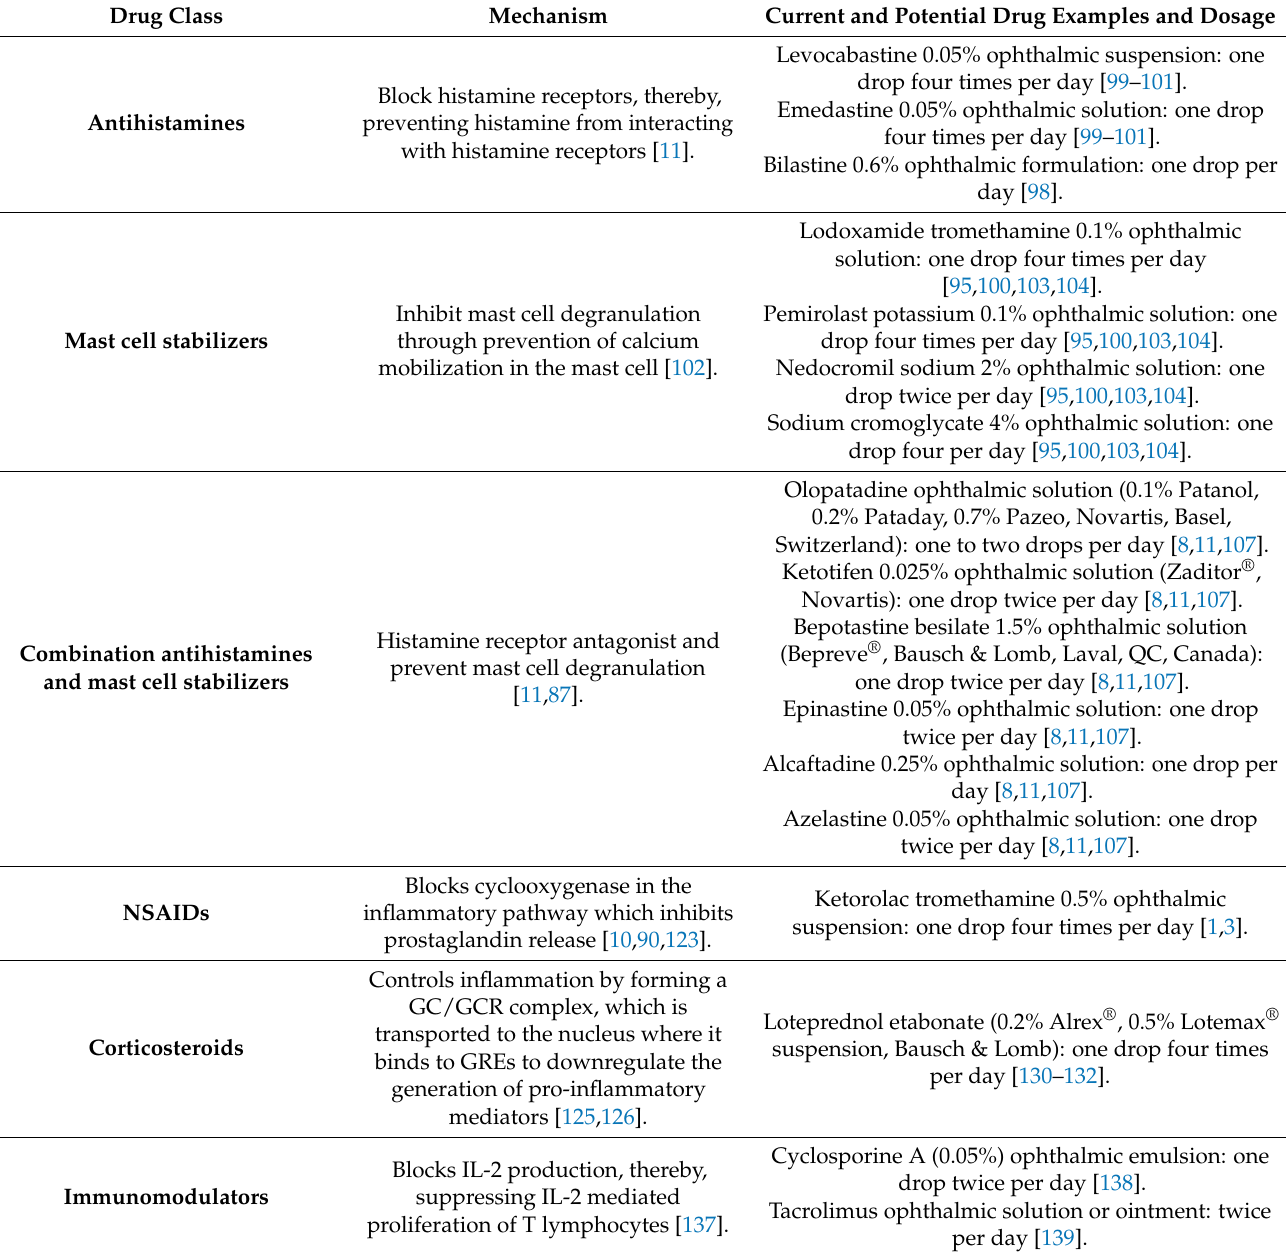
Table 1. Current therapeutic classes for the treatment of allergic